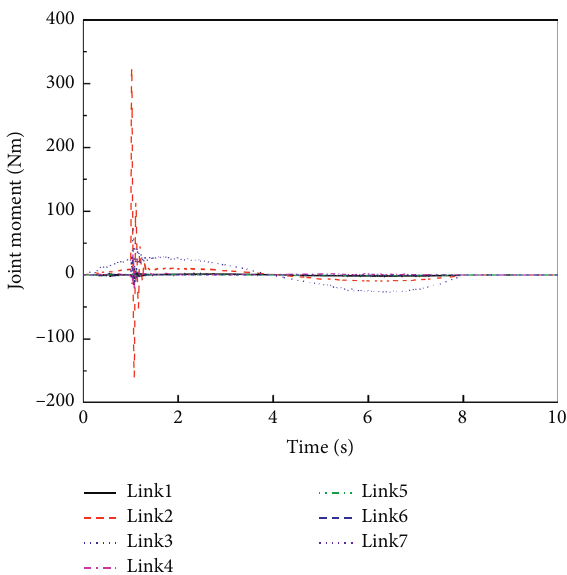
Figure 8: Joint control torque (Nm).